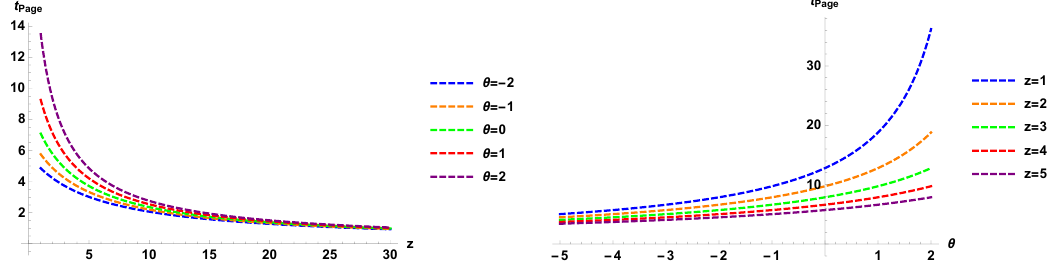
Figure 6 . Page time when the matter is described by a HV QFT d +2 with θ m 6 = 0 as a function of: ( Left ) z for d = 3 , θ values of z . Here we set A = V